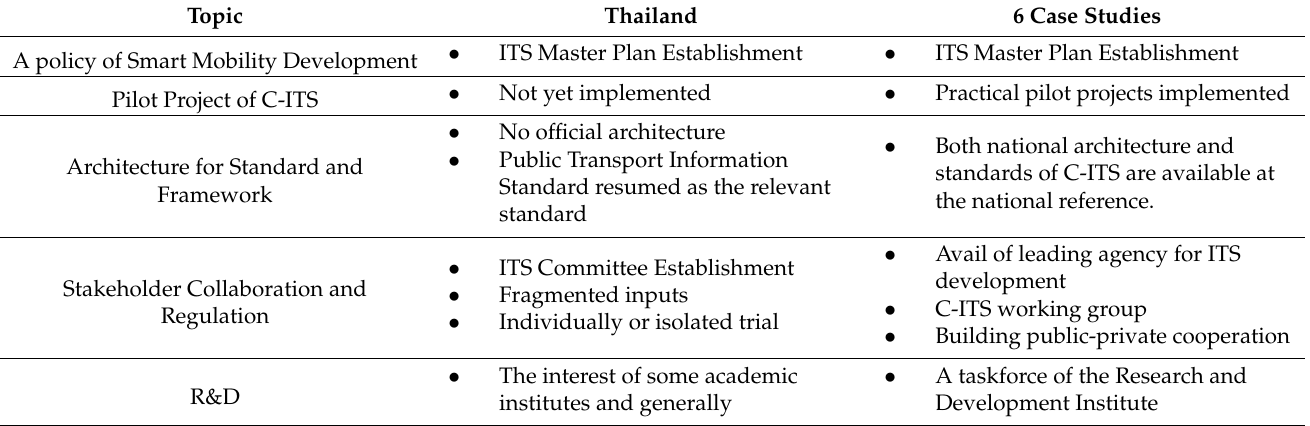
Table 2. Comparison of C-ITS development between Thailand and the six-case study.